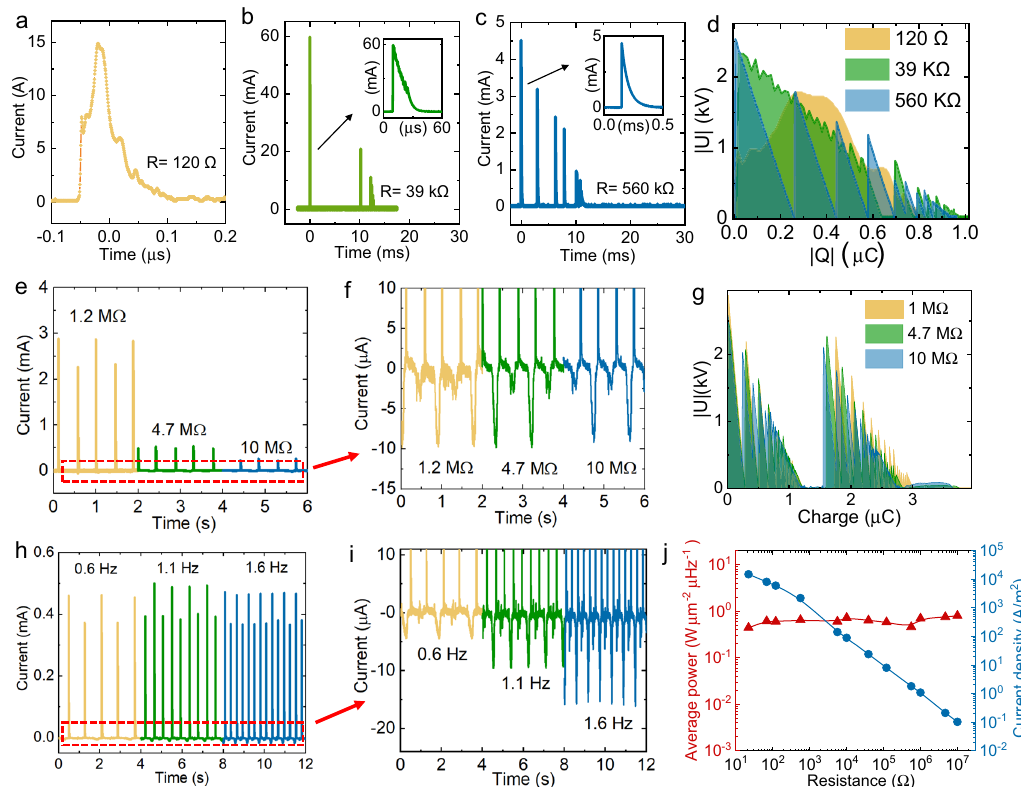
Fig. 3 Evidence for the proposed mechanism. The current output at stage 1 with the resistance of a 120 Ω , b 39 k Ω , and c 560 k Ω . d U – Q plot of OCT- TENG generated from stage 1 with the resistance of 120 Ω , 39 k Ω , and 560 k Ω . Output currents from the ON state (stages 1 and 3): e inversely proportional to the load resistance, and h , independent of the frequency. Output currents generated from the OFF state (stages 2 and 4): f independent of load resistance and i proportional to the frequency. g U – Q plot of the OCT-TENG with a load resistance of 1 M Ω , 4.7 M Ω , and 10 M Ω . j the average power density and peak current density depending on the load